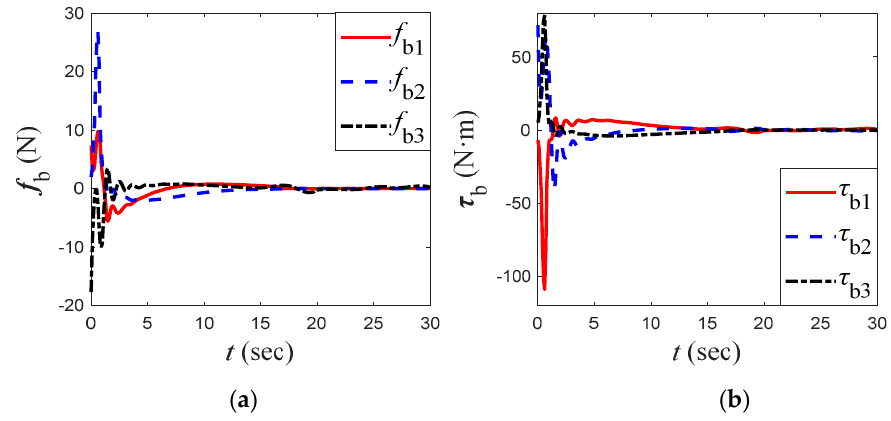
Figure 14. ( a ) Control forces of the platform; ( b ) Torques of the platform.